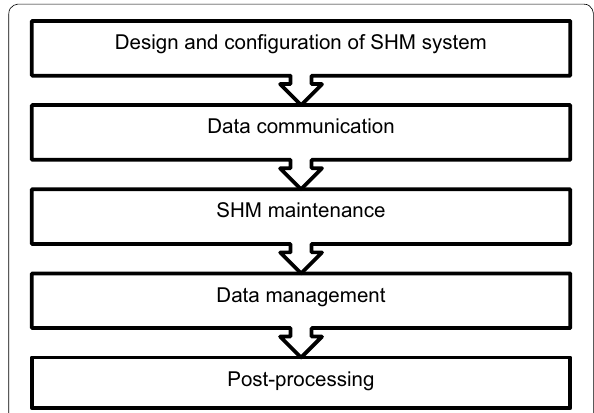
Fig. 1 Visual schematic of the SHM methodology (Newell et al.